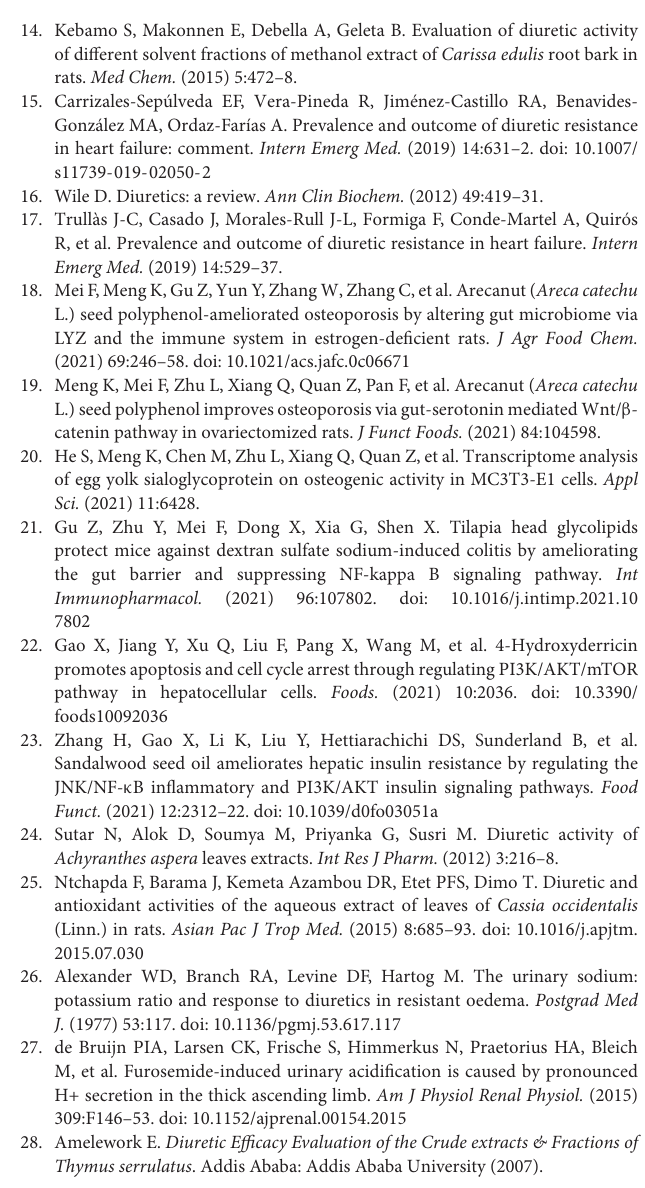
Supplementary Figure 1 | Physicochemical property of coconut ( Cocos nucifera L.cv.Wenye.No. 4) water. Supplementary Figure 2 | Effects of CW on the body weight (A) , food consumption (B) and water intake (C) of rats. Values expressed as mean ± SD ( n = 9). Supplementary Figure 3 | The representative bands of AQP1, AQP2, and AQP3 protein expression from different groups were detected by Western